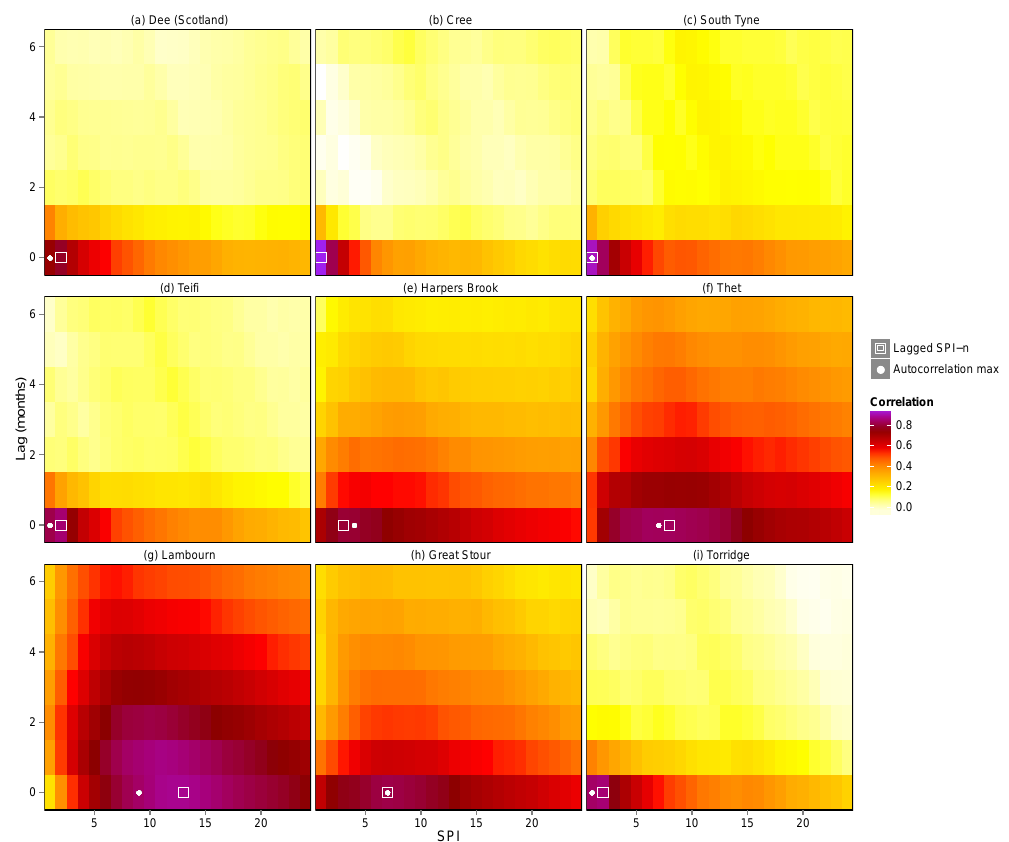
Figure 10. Heat maps for case study catchments showing correlation between SSI-1 lagged by 0–6 months and SPI accumulation peri- ods of 1–24 months. The lagged SPI- n is shown, as is the longest n -month period for which there is significant autocorrelation in SSI-1 (autocorrelation